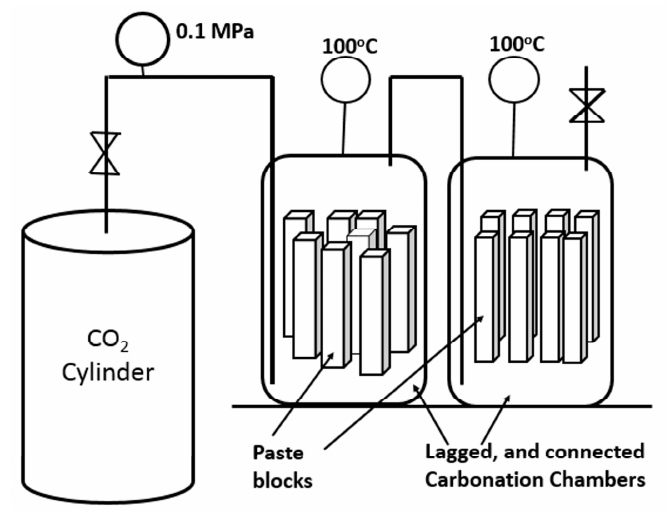
Figure 2. Experimental schematic of di ff usion of CO 2.